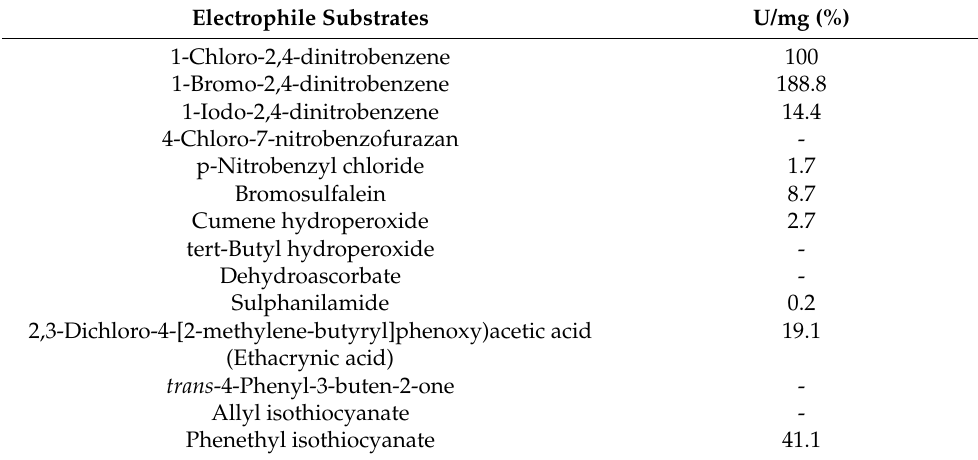
Table 1. Substrate specificity of Mm GSTP1-1. The results represent the mean of triplicate determi- nations, with a variation of less than 5% in all cases. The specific activity of the enzyme against the model substrate CDNB is defined as 100%.